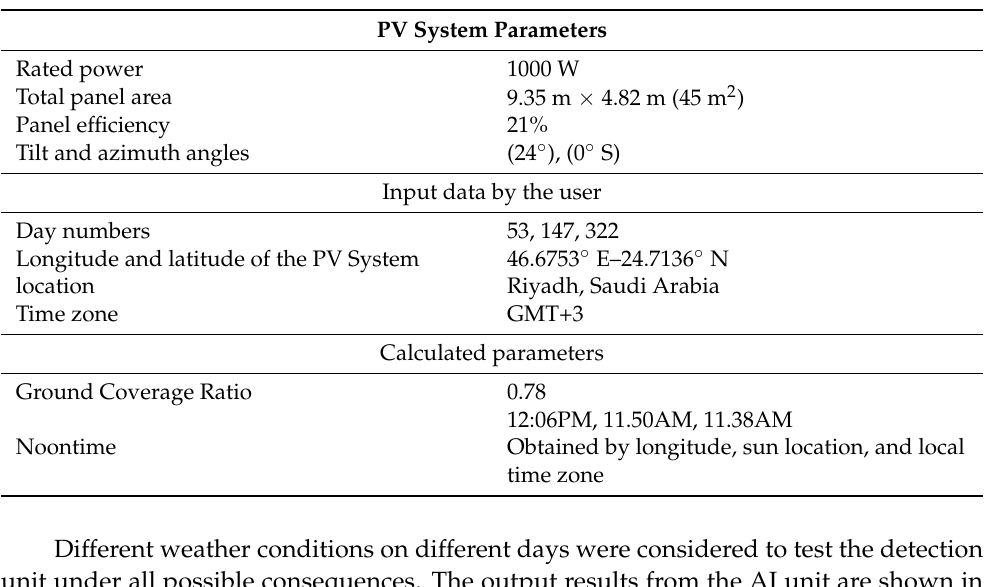
Figure 17. Estimated and actual PV output power during a partly cloudy day. The outcome figures, Figure 16 and Figure 17, show only three plots for the PV sys- tem: the estimated delivered power, actual delivered power with cleaned panels, and ac- tual delivered power with uncleaned panels, while the proposed system can virtually ac- commodate any type of PV power data. The reason for not showing all collected data is to not repeat the previously shown figures as well as to explain the basic process with obvious graphs. However, the completed analysis for all available data, including weekly and monthly cleaned panel data, are illustrated in Table 4. The final decision of the AI system not only relies on the comparison between the estimated and actual PV output power, but also depends on a deep intelligent computa- tional analysis where the dust versus PV power, as in Equation 4, is one of the main key detection factors. For instance, on May 27 th (and for the monthly cleaned panel), the order was not given for cleaning due to the existence of clouds; however, on the same day (and for the annually cleaned panel), the decision for cleaning the panel was suggested, where the AI system detected a high level of dust despite the presence of clouds. Moreover, de- spite the fact that the dust level on November 22 nd exceeded 0.15 g/m 2 , the dust detection